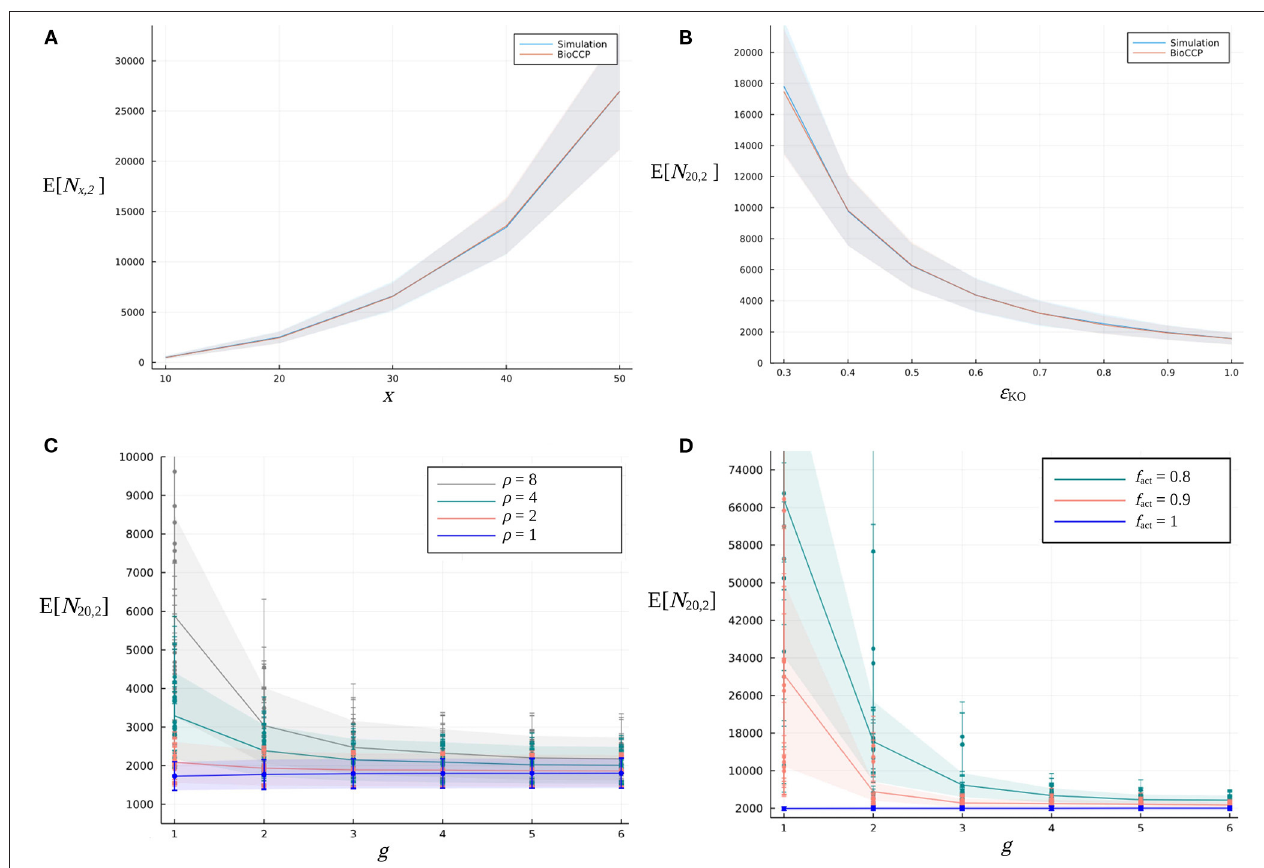
FIGURE 5 | Relation between the expected value of the plant library size for full coverage of pairwise combinations of gene knockouts and design parameters of a multiplex CRISPR/Cas experiment. (A) Effect of an increasing number of x target genes on E[ N x ,2 ]. (B) Effect of the global knockout efficiency ǫ KO on E[ N 20,2 ]. The blue curve indicates the simulation-based results, while the red curve indicates the BioCCP-based results. The width of the shaded area around these curves represents σ [ N 20,2 ]. In each of the graphs, the parameter under investigation is varied while the values of the other parameters are fixed at the default values of the CRISPR/Cas experiment as specified in Table 2 . (C) Combined effect of parameter ρ of the gRNA frequency distribution for an increasing number of g gRNAs per gene on E[ N 20,2 ]. (D) Effect of the fraction f act of active gRNAs for an increasing number of g gRNAs per gene on E[ N 20,2